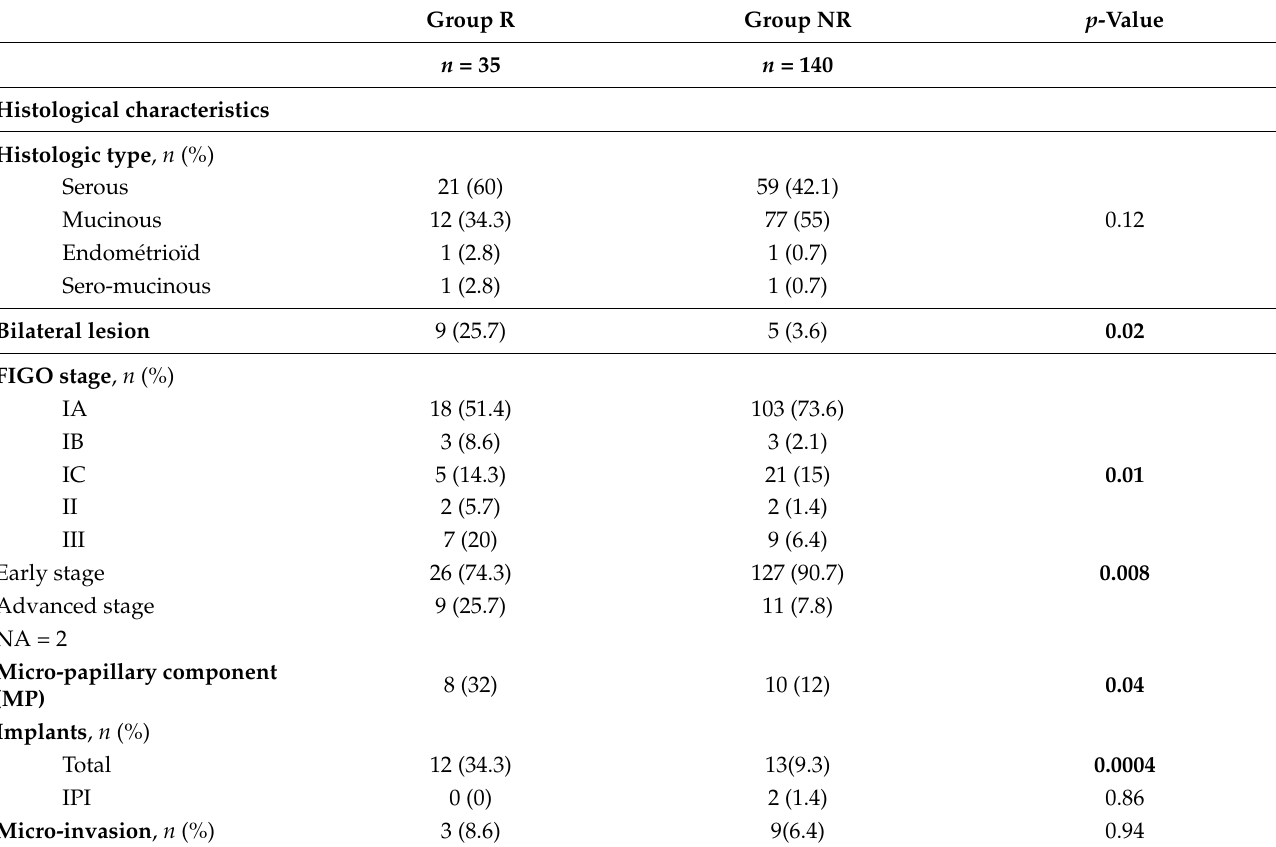
Table 4. Histological characteristics according to recurrence status.